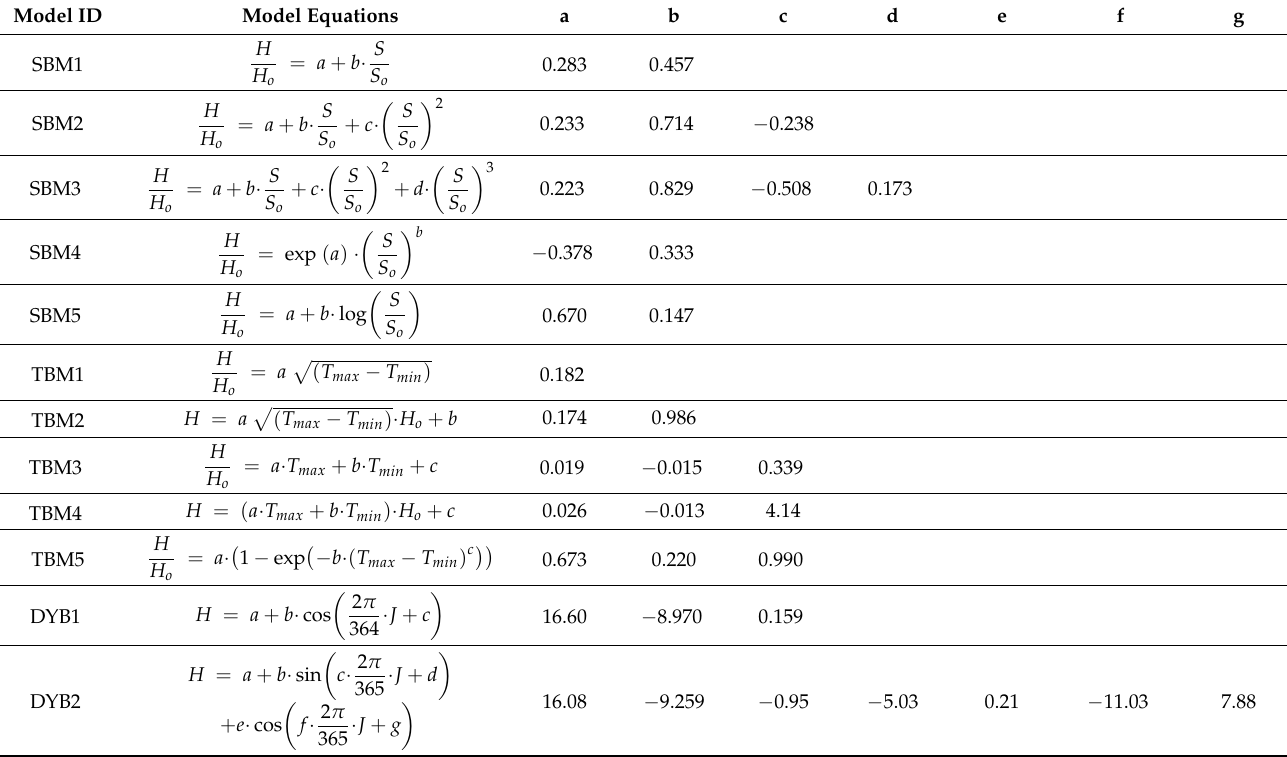
Table 8. Regression coefficients for each of the models